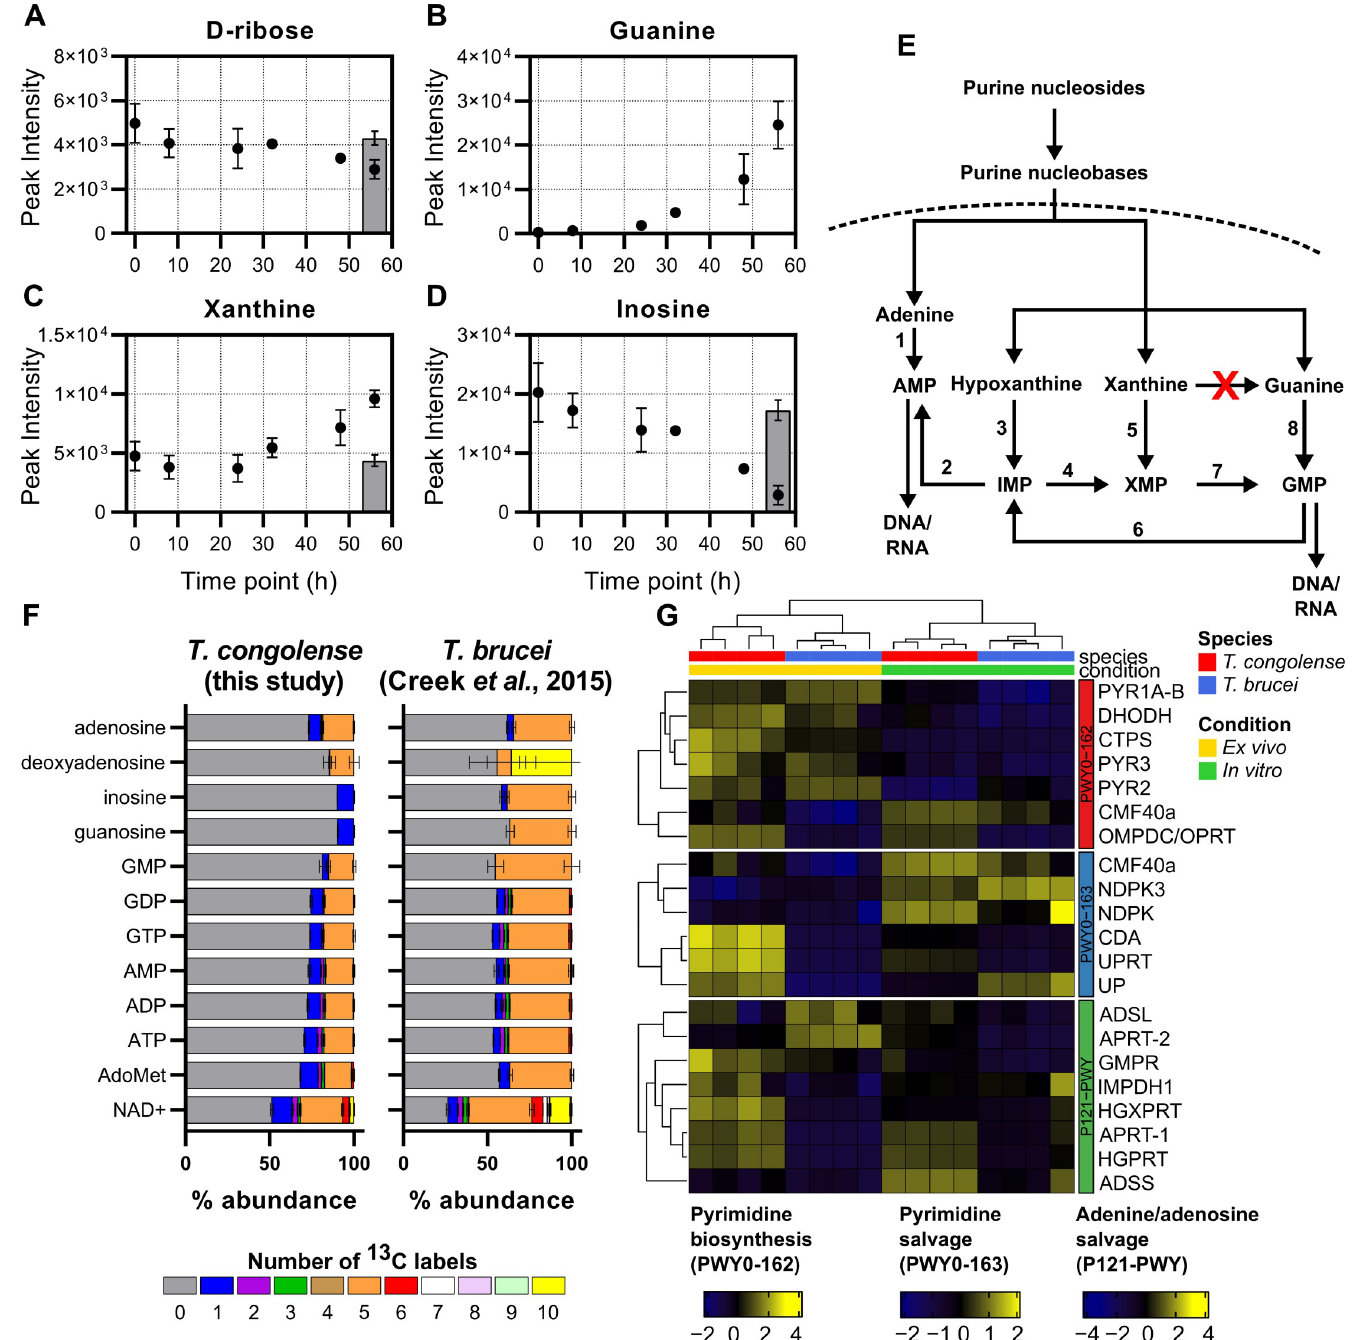
Fig 5. Nucleotide metabolism in T . congolense . Supernatant analysis of T . congolense in vitro cultures showing changes in abundance of D-ribose (A), guanine (B), xanthine (C) and inosine (D) over 56 hours. Grey bar indicates a negative medium control group E) Simplified overview of purine salvage and synthesis in trypanosomatids (adapted from [148]). Numbers indicate the following enzymes: 1, APRT; 2, AD; 3, HGPRT; 4, IMPD; 5, HGXPRT; 6, GMPR; 7, GMPS; 8, HGPRT. Red cross indicates guanine deaminase, which is not encoded/annotated in the T . congolense genome (based on current assembly). F) Comparison of glucose-derived purine carbon labelling in T . congolense and T . brucei [45]. Colours indicate the number of 13 C atoms in each metabolite. G) Comparative RNAseq analysis of T . congolense and T . brucei under both in vitro and ex vivo conditions. Gene IDs from top to bottom: PWY0-162 (pyrimidine biosynthesis): PYR1A-B, glutamine hydrolysing carbomoyl phosphate synthase, TbTc_1631; DHODH, dihydroorotate dehydrogenase (fumarate), TbTc_0620; CTPS, cytidine triphosphate synthase, TbTc_0920; PYR3, dihydroorotase, TbTc_3801; PYR2, aspartate carbamoyltransferase, TbTc_1630; CMF40a, nucleoside diphosphate kinase, TbTc_5784; OMPDC/ OPRT, orotidine-5-monophosphate decarboxylase/orotate phosphoribosyltransferase, TbTc_0735. PWY0-163 (pyrimidine salvage): CMF40a, nucleoside diphosphate